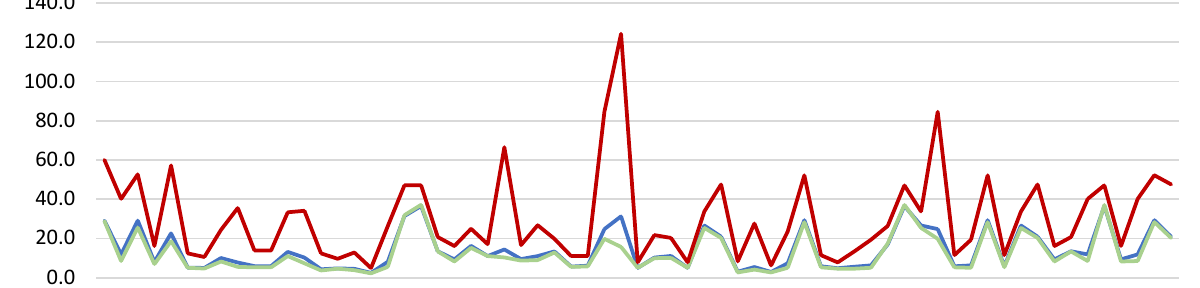
Figure 7. PM 10 concentration ( µ g · m − 3 ) indoors.